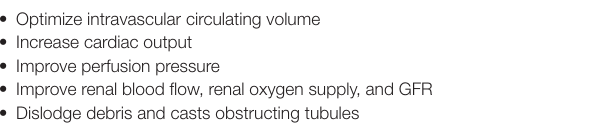
TABLE 1 | Goals of fluid resuscitation in